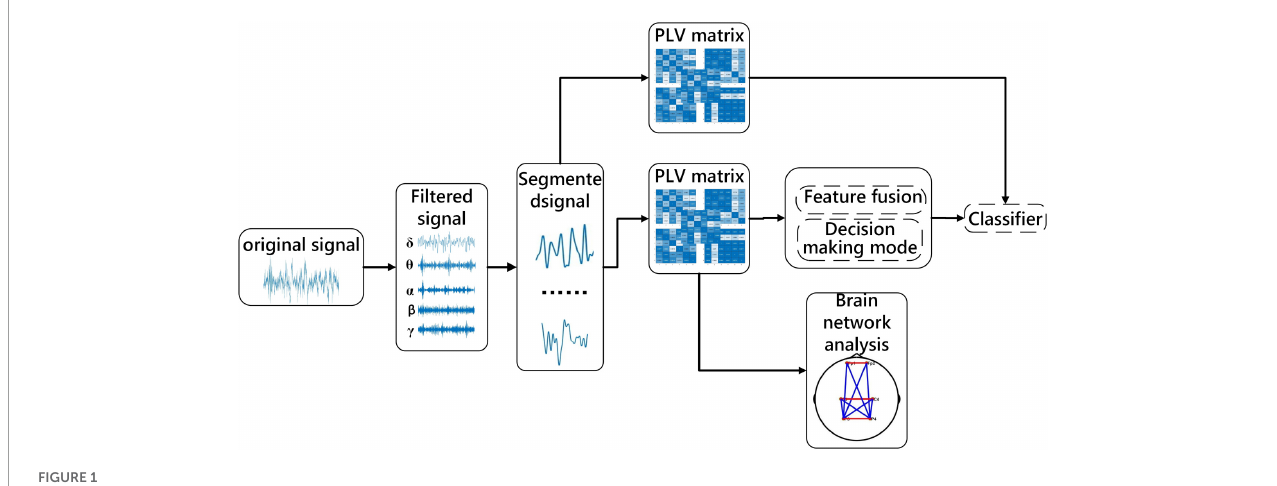
FIGURE1 The flow diagram of the proposed framework.